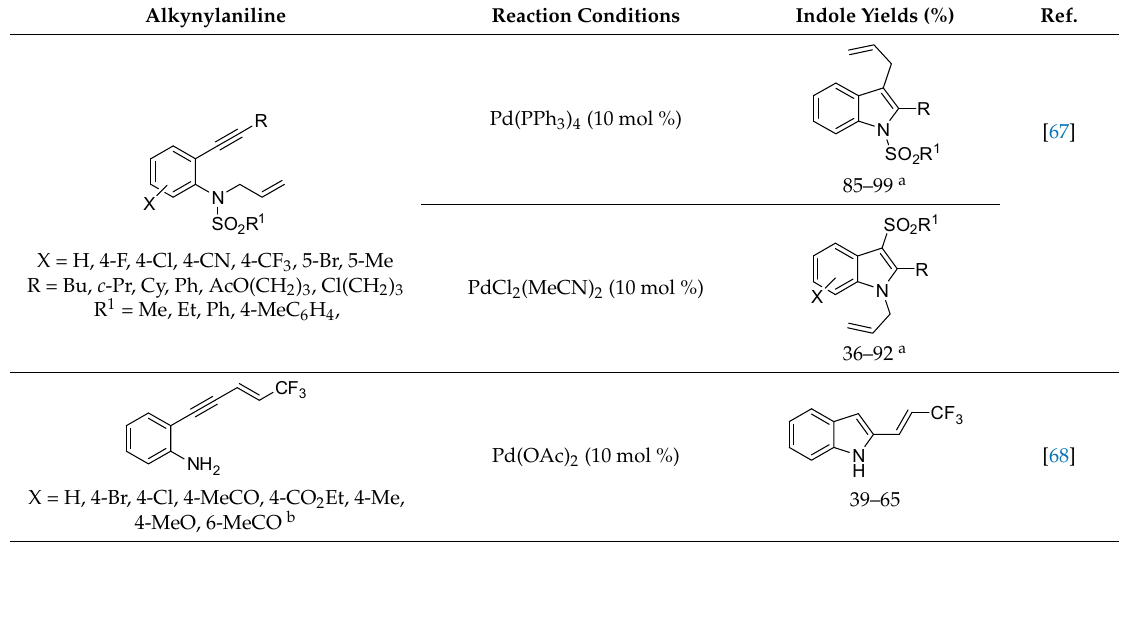
Table 2. Cyclization of alkynylanilines under palladium catalysis. Alkynylaniline Reaction Conditions Indole Yields (%) Ref.